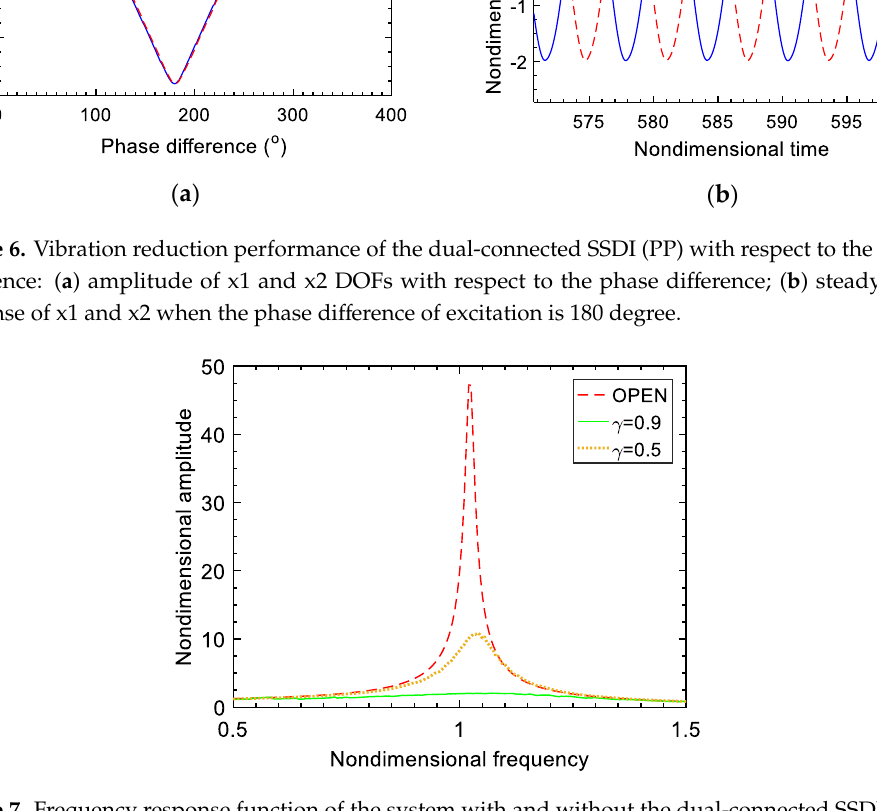
Figure 7. Frequency response function of the system with and without the dual-connected SSDI (PP).